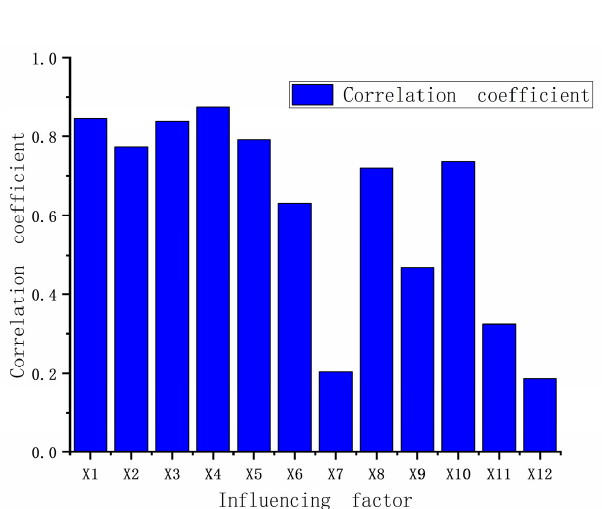
Figure 3. Correlation intensity between characteristic parameters and gas emission.